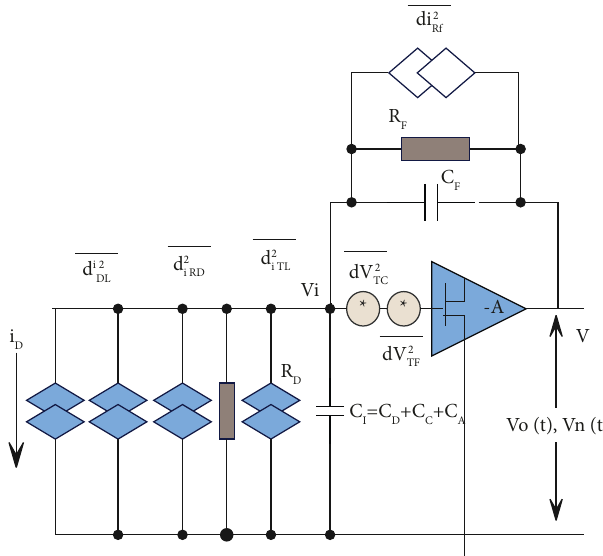
Figure 1: Charge-sensing amplifier signal and noise equivalent